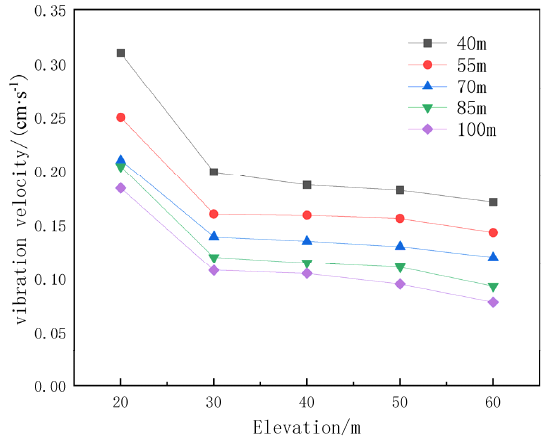
Figure 5. Horizontal radial vibration velocity.